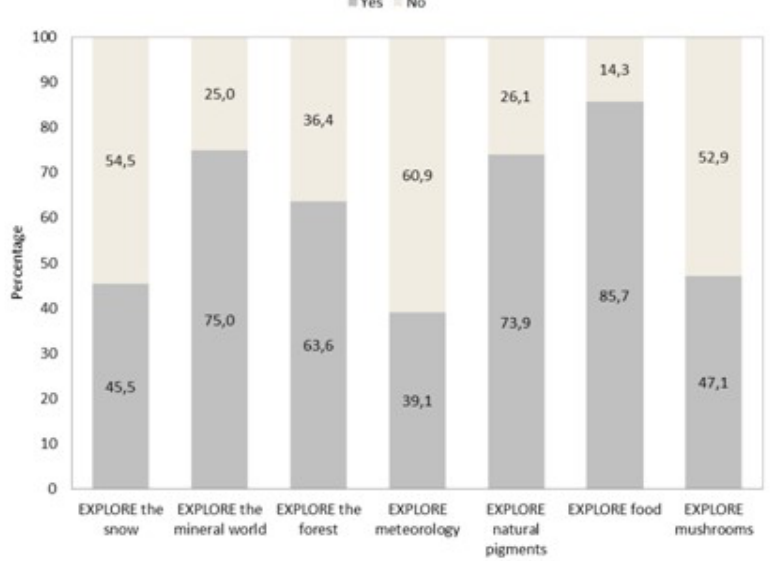
Figure 7. Percentage of responses to the queston: "Will you introduce some methodological contents of the EXPLORE course in your day-to-day teaching